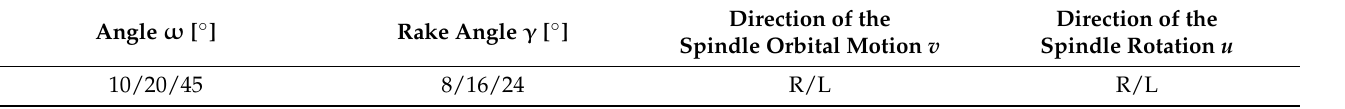
Table 5. Research Table 5. Research plan. Table 5. Research plan.